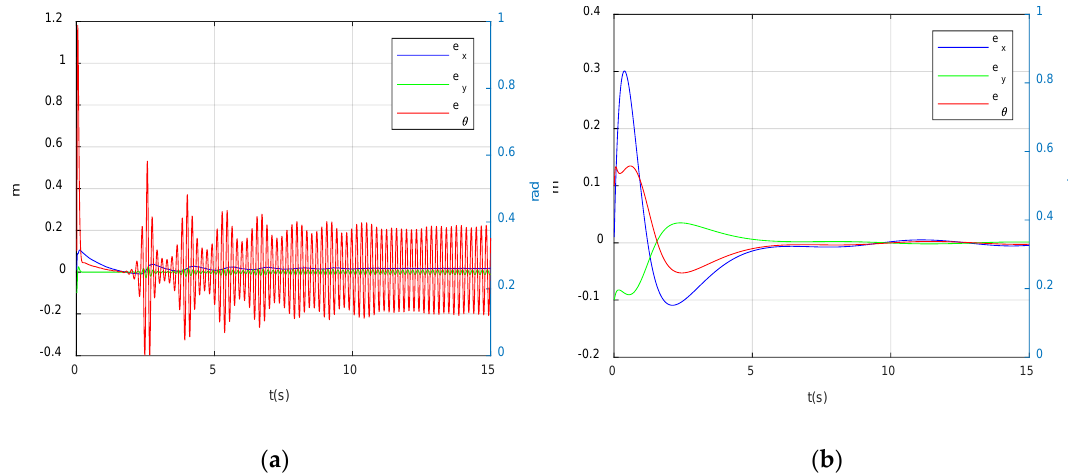
Figure 14. Performance of linear velocity by TRNC ( a ) and proposed controller ( b ); angular velocity by TRNC ( c ) and proposed controller ( d ).